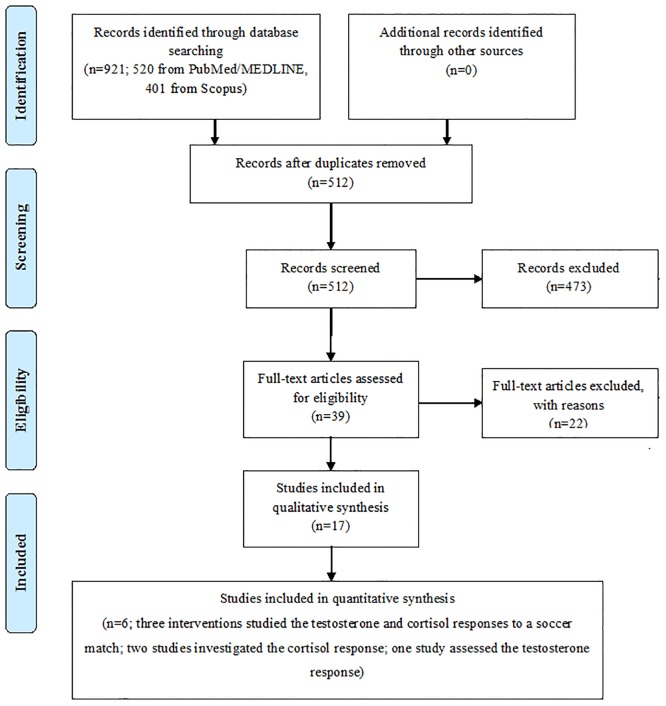
Preferred Reporting Items for Systematic Reviews and Meta-analysis (PRISMA) flow-chart.